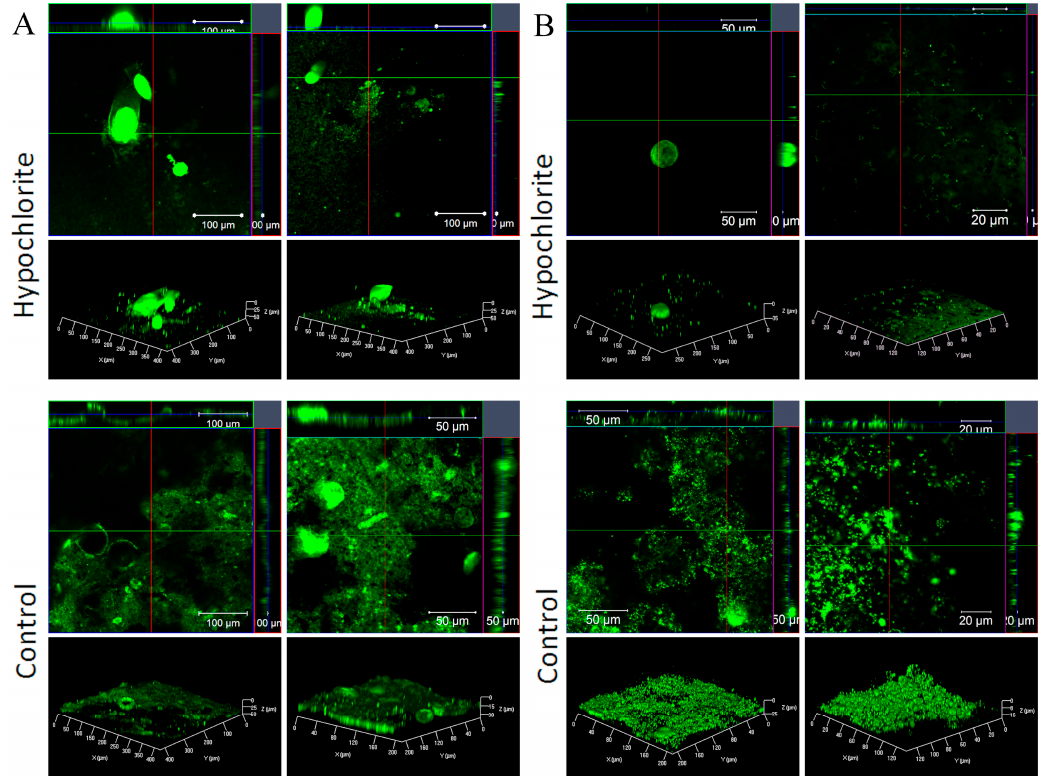
Figure 6. Confocal microscopy images of biofilm on the surface of TeknoTar coated specimens. The biofilms were washed and stained with SYTO9, and Z-stacks of each were acquired by CLSM. Upper panels, orthogonal projections of Z-stacks; bottom panels, 3D projections. Two random microscope fields are presented, ( A ) after one month; ( B ) after three months.